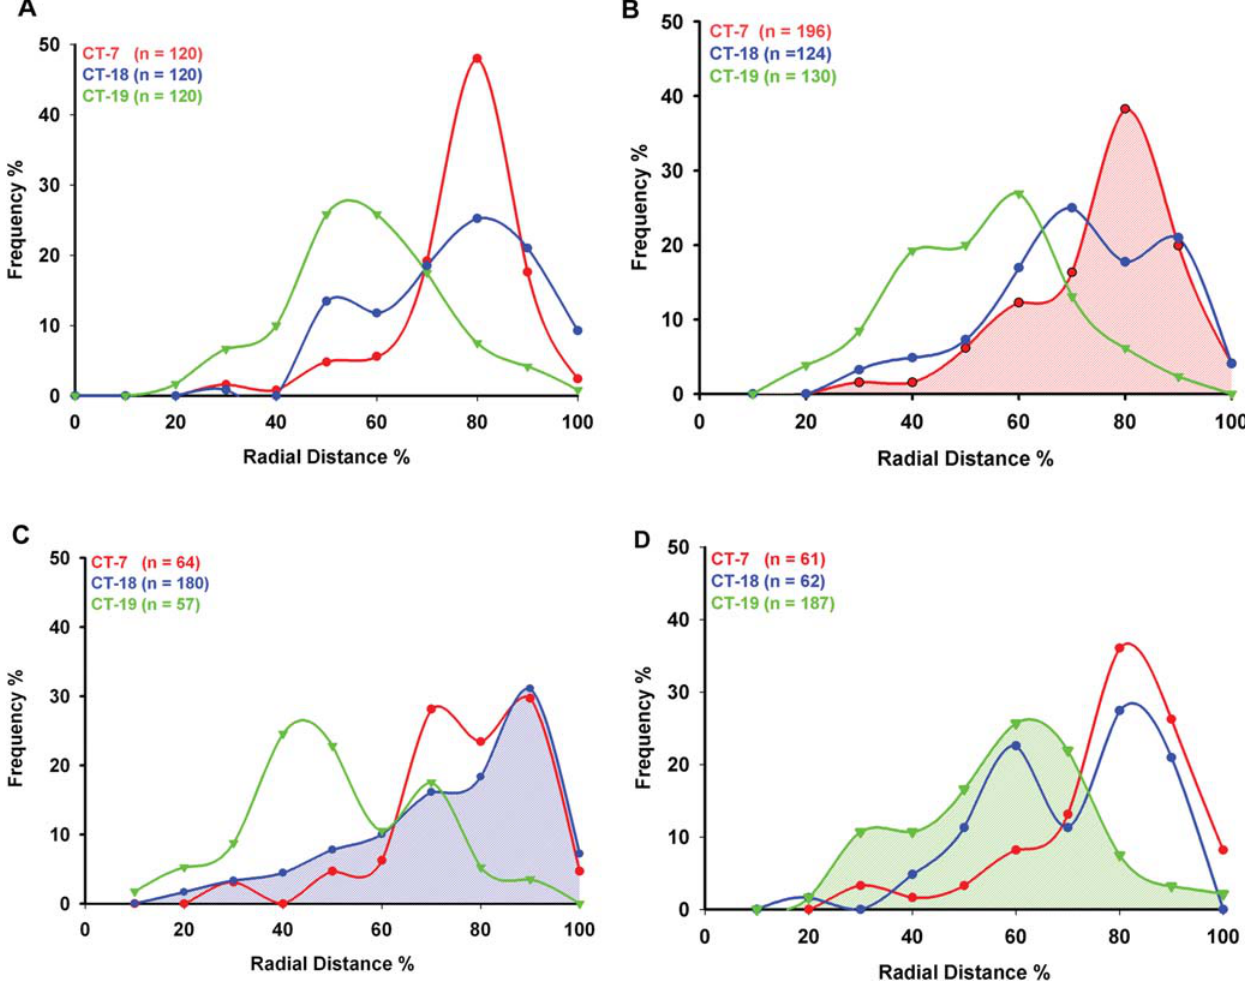
Figure 4. Radial distance measurement profiles of chromosome territories in A: DLD-1 B: DLD-1 + 7, C: DLD-1 + 18 and D: DLD-1 + 19. X-axis: Radial Distance (%); Y-axis: Frequency (%); 0 or origin: center of the nucleus; 100%: nuclear periphery; Red: Chromosome 7; Green: Chromosome 19; Blue: Chromosome 18.